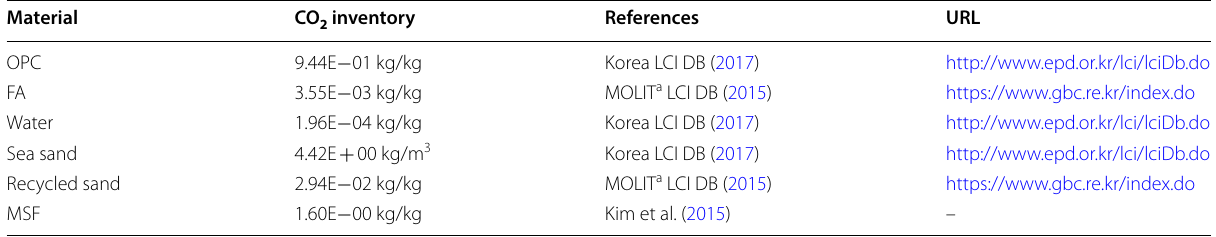
a Ministry of land, infrastructure and transport (Rep. of Korea).